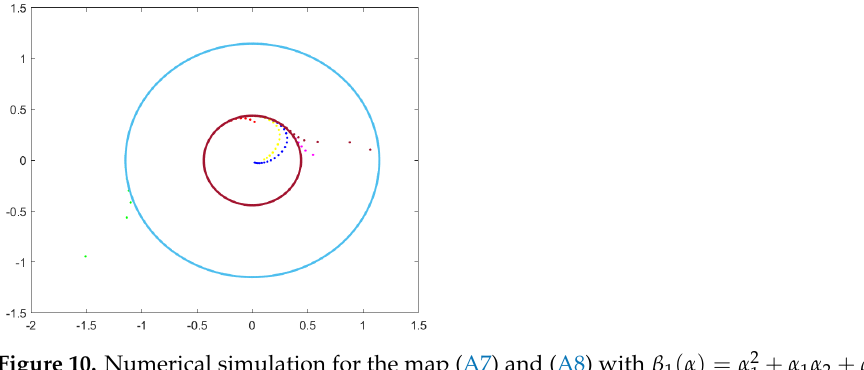
Figure 10. Numerical simulation for the map (A7) and (A8) with β 1 ( α ) = α 2 α 1 + 3 α 2 and L 0 = 1, α 1 = − 0.01, α 2 = −